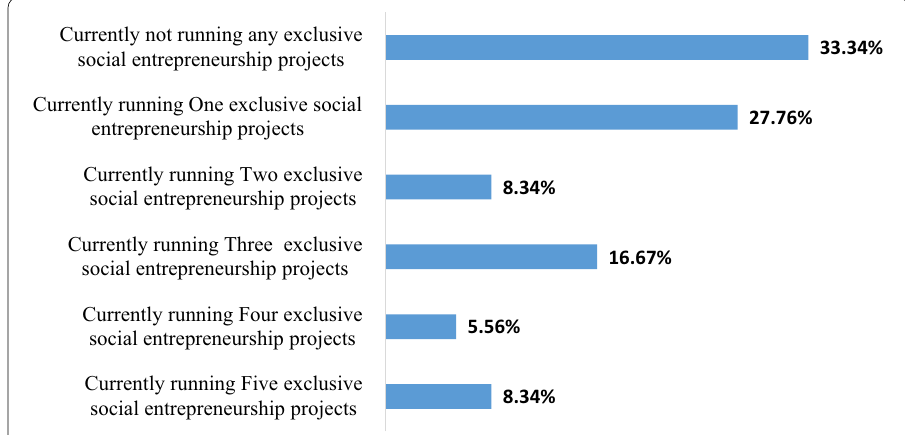
Fig. 10 Frequency of the currently running exclusive social entrepreneurship